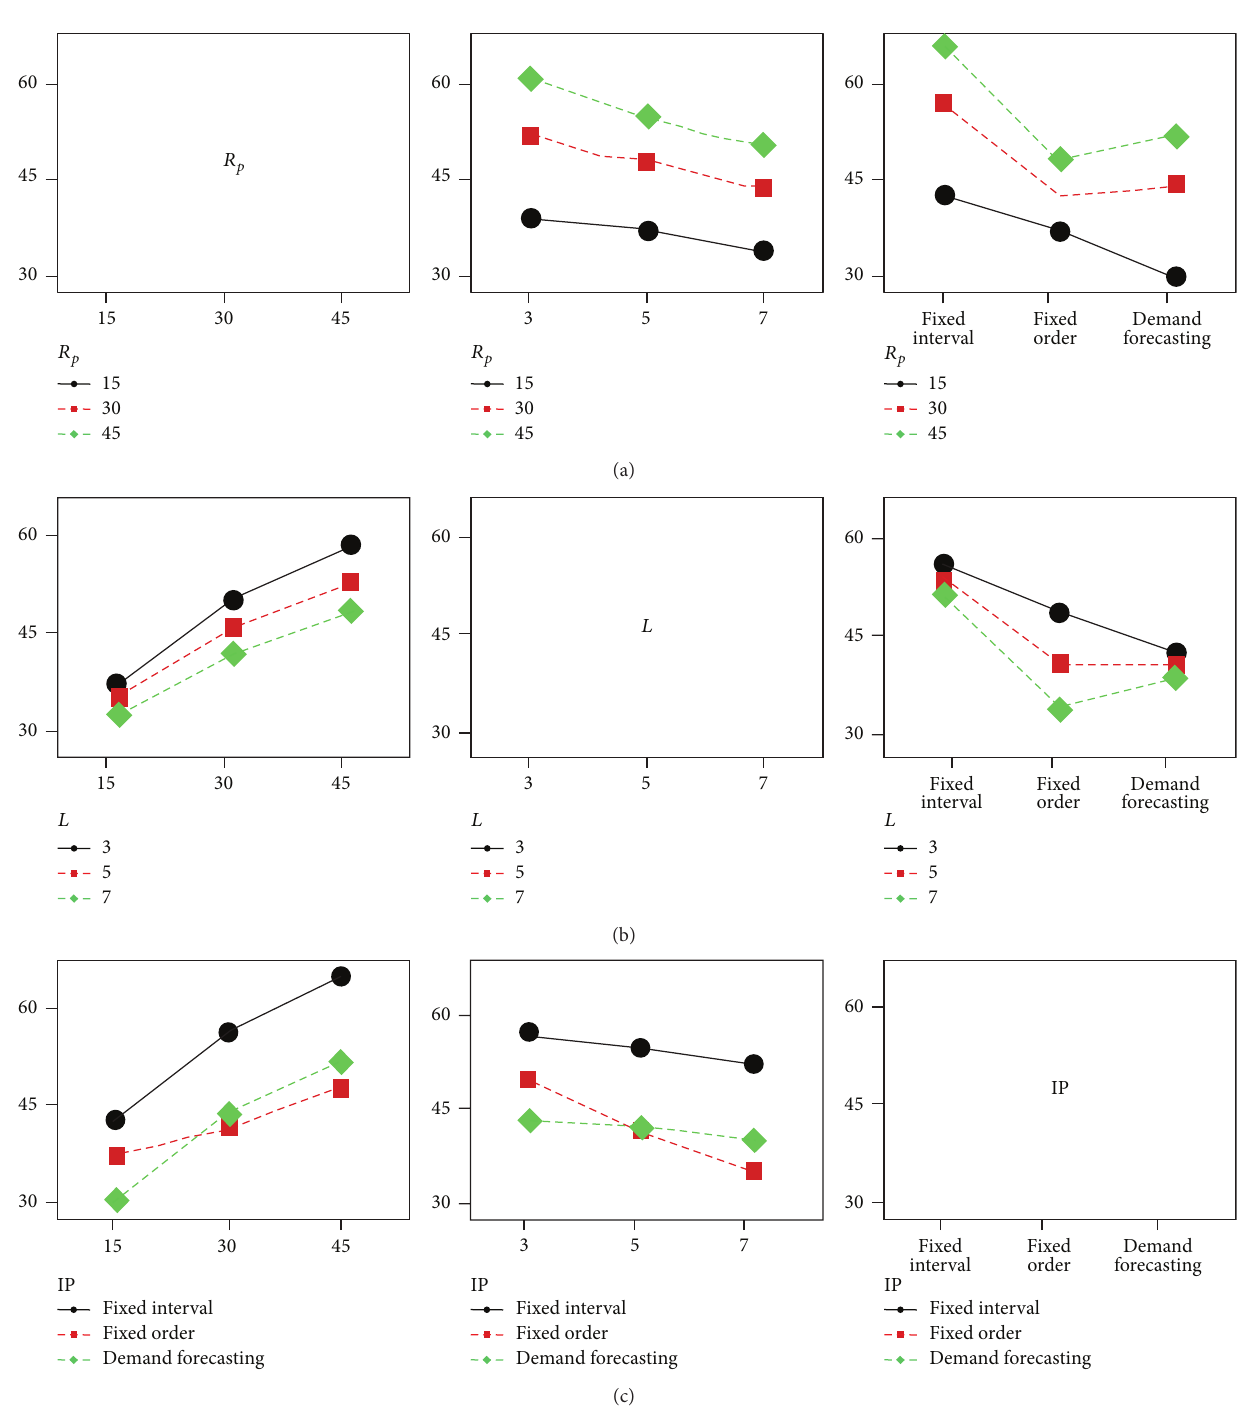
Figure 4: Interaction plot for product 𝐶 : average of inventory